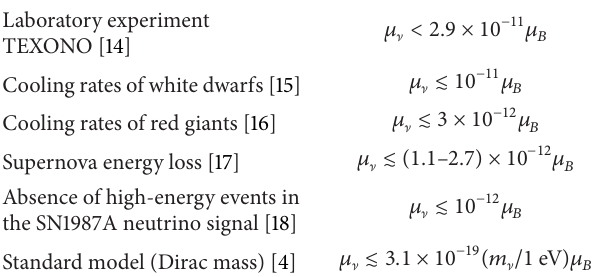
Table 1: Bounds on the neutrino magnetic moment.